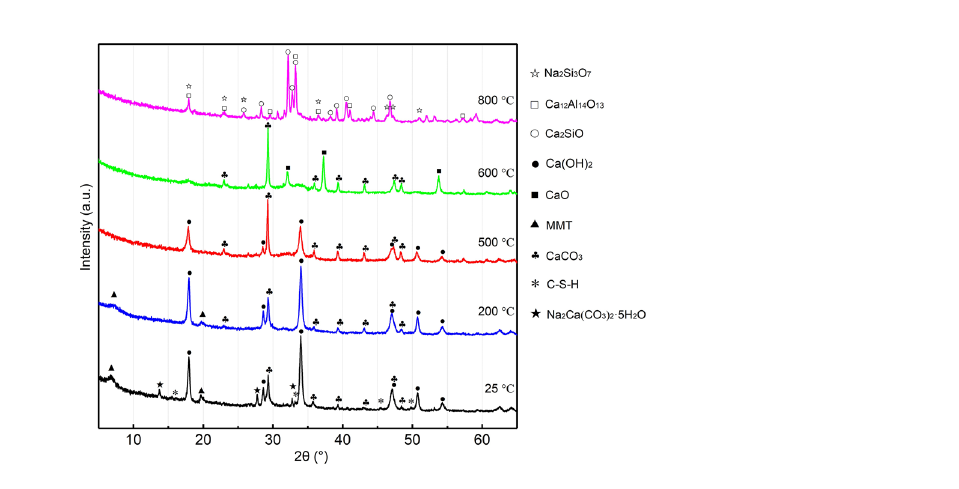
Figure 8. XRD patterns for composite particles at different